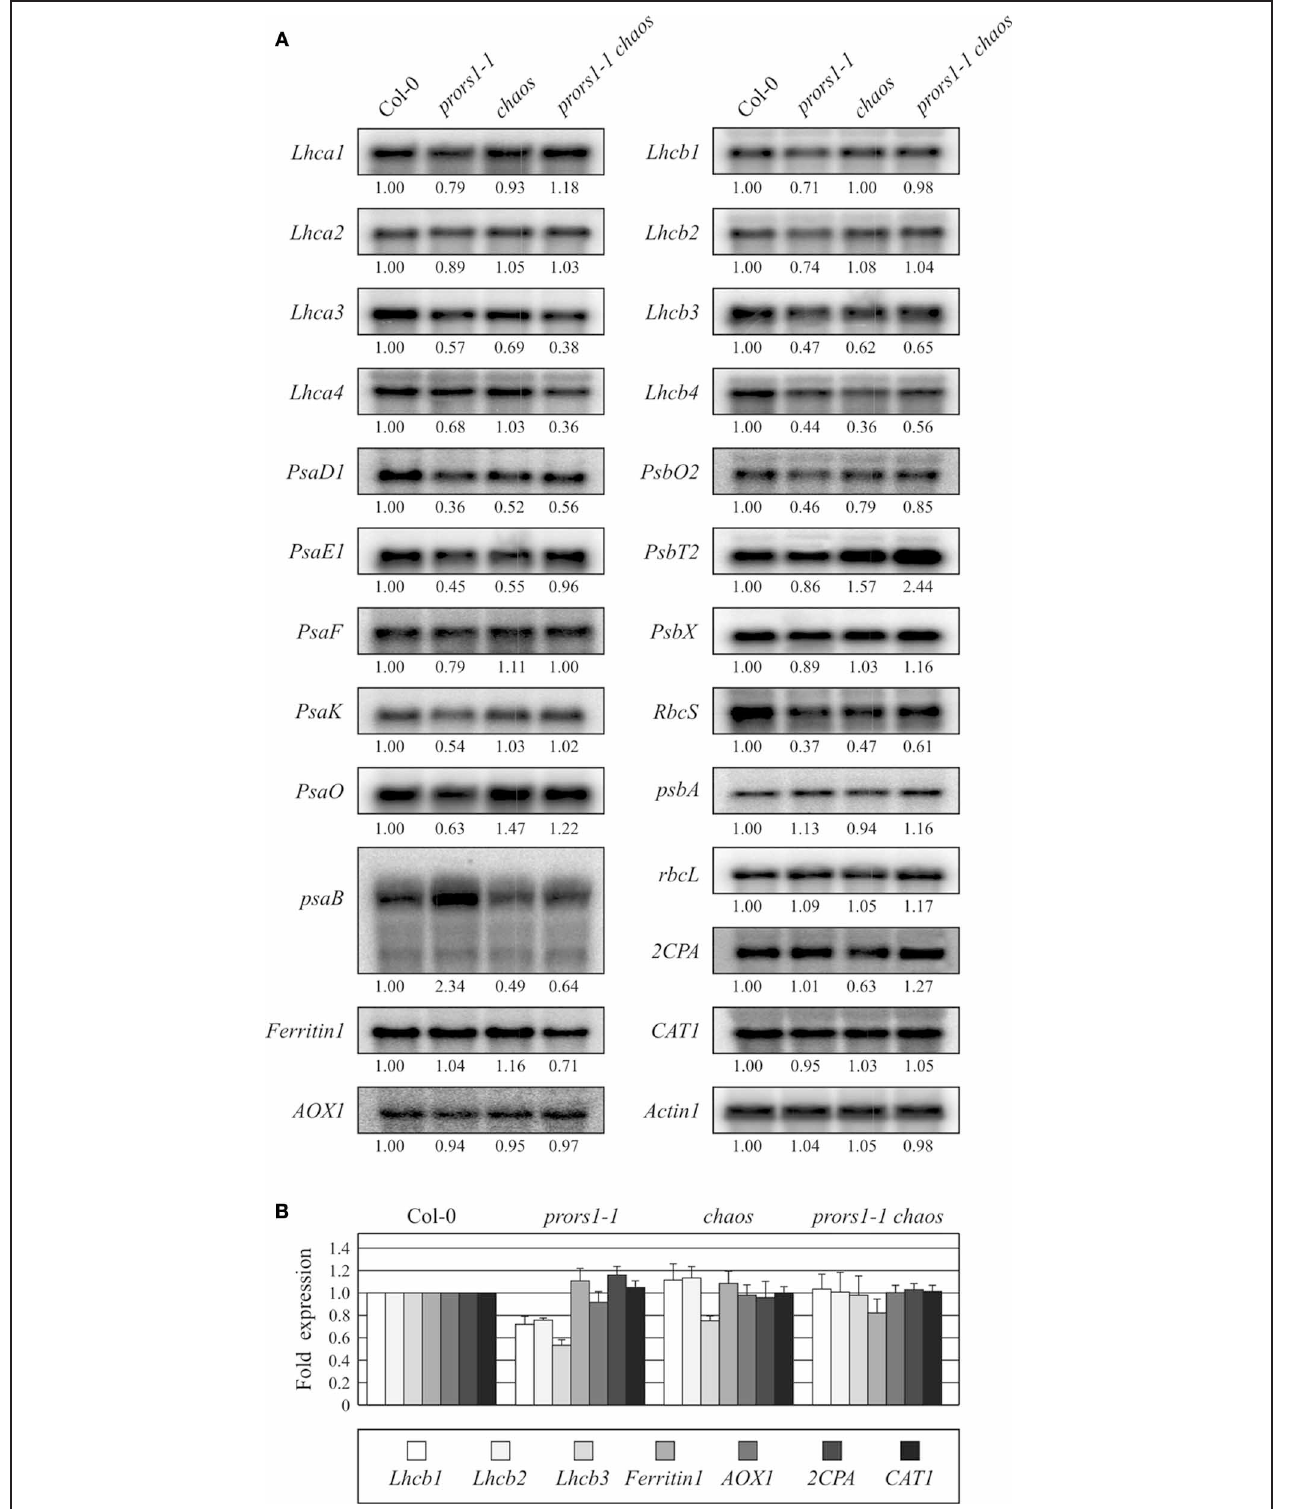
FIGURE 5 | Expression analysis of photosynthesis and antioxidant genes in WT (Col-0) and mutant ( prors1-1 , chaos, and prors1-1 chaos ) leaves. (A) Twenty microgram samples of total RNA from light-adapted WT, prors1-1 , chaos, and prors1-1 chaos mutant plants were size-fractionated by agarose